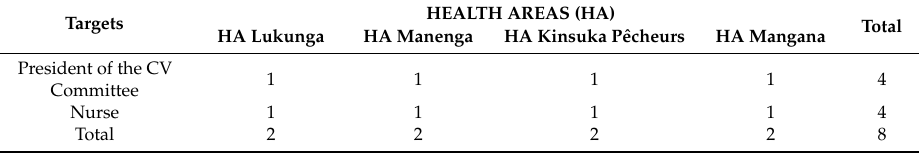
Table 2. Distribution of sample size by health area and by target for in-depth